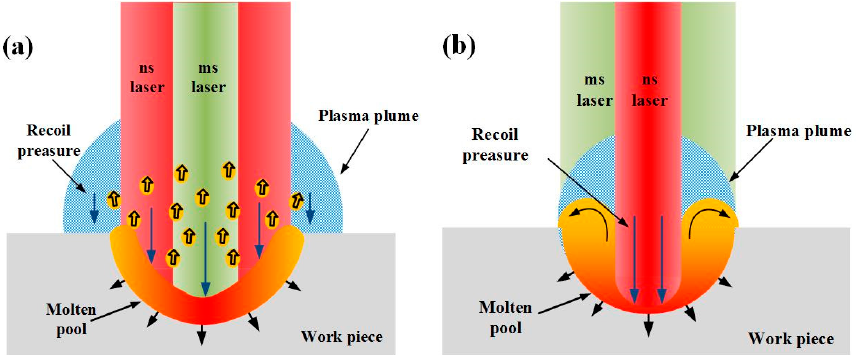
Figure 6. Schematic illustration of the laser ablation ( a ) the ns spot is larger ( b ) the ms spot is larger.